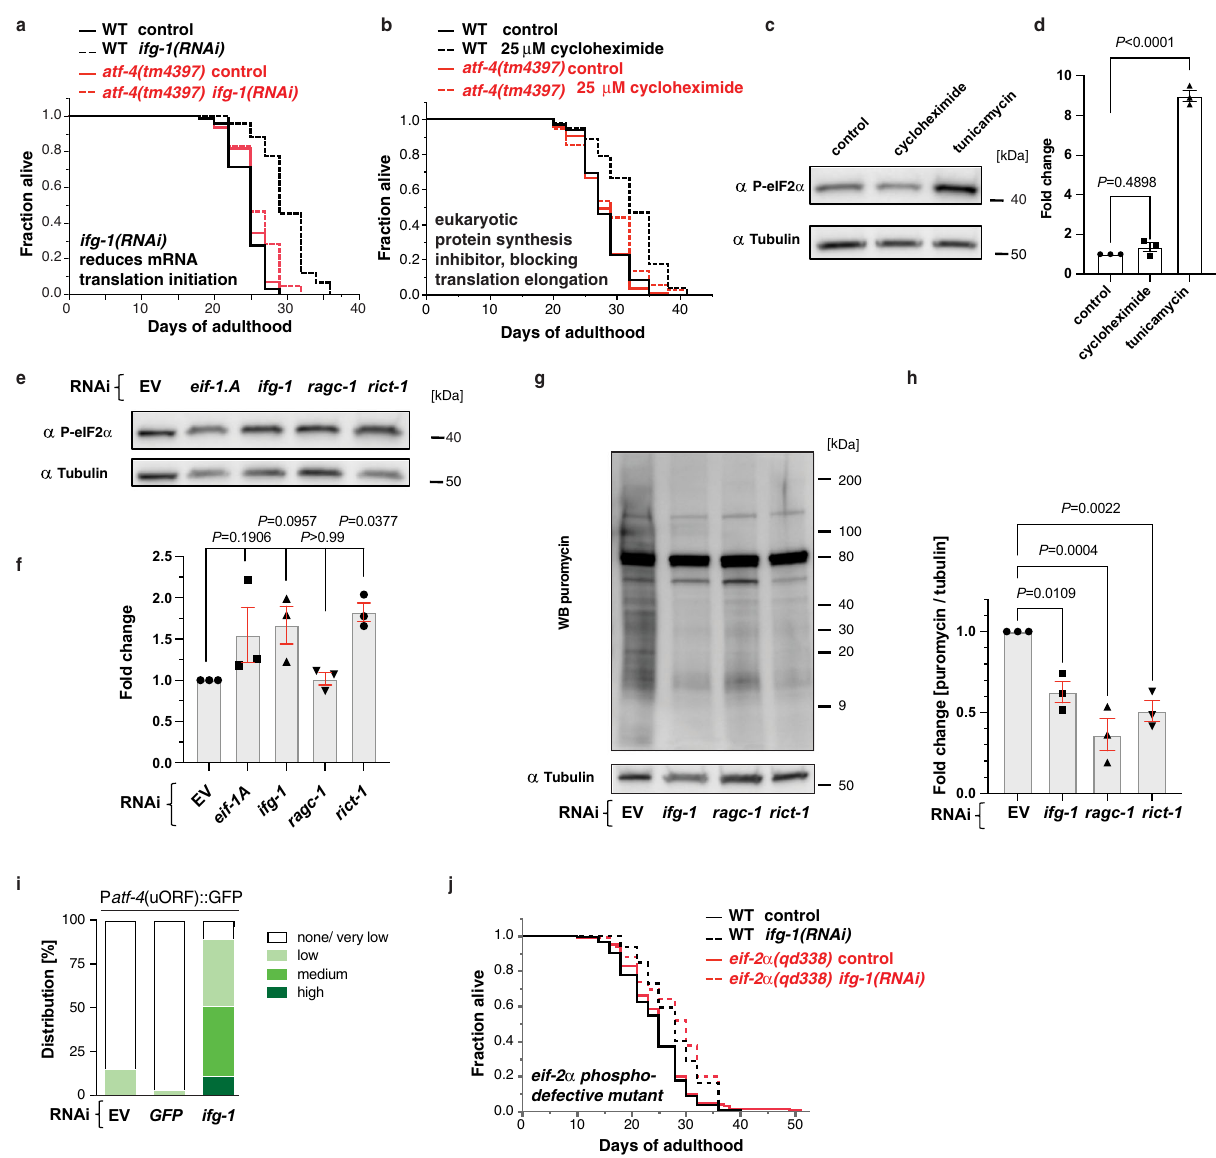
Fig. 2 ATF-4 mediates lifespan extension from translation inhibition. a Adult-speci fi c knockdown of ifg-1 extended the lifespan of WT animals but not atf- 4(tm4397) mutants. b Adult-speci fi c treatment with 25 μ M cycloheximide increased lifespan dependent upon atf-4 . c Representative western blots and quanti fi cation ( d ) showing that treatment with 35 μ g/ml tunicamycin for 4 h dramatically increased eIF2 α phosphorylation levels in L4 stage animals, while treatment with 7.2 mM cycloheximide for 1 h did not. Mean± SEM. n = 3 biological replicates. One-way ANOVA with post hoc Tukey. e Representative western blots and quanti fi cation ( f ) showing the effects of adult-speci fi c knockdown of eif-1.A , ifg-1 , ragc-1 , or rict-1 on eIF2 α phosphorylation levels. Mean± SEM. n = 3 biological replicates. One-way ANOVA with Dunnett ’ s post-test compared to EV. g Representative western blots of puromycin incorporation assay and quanti fi cation ( h ) showing that adult-speci fi c knockdown of ifg-1 , ragc-1 , or rict-1 decreased translation. Mean ± SEM. n = 3 biological replicates. One-way ANOVA with Bonferroni post-test. i Quanti fi cation of GFP fl uorescence showing that adult-speci fi c ifg-1 knockdown increases expression of P atf-4 (uORF)::GFP. j Adult-speci fi c knockdown of ifg-1 comparably extended the lifespan of WT animals and eif-2 α / y37e3.10(qd338) phosphorylation-defective mutants. For statistics and additional trials in ( a ), ( b ), and ( j ), see Supplementary Data 1. For western blots, source data are provided in Source data File. Fig. 3c, d). Notably, ATF-4 overexpression upregulated several suggesting that ATF-4 functions in tandem with HSF-1/HSF1. small heat shock protein (HSP) genes that are also controlled by Together, the data suggest that ATF-4 enhances proteostasis HSF-1/HSF (heat shock factor) and DAF-16/FOXO (Fig. 3d), and mechanisms that have been linked to longevity. are typically induced by longevity-assurance pathways 1 . Each of Other fi ndings further linked ATF-4 to longevity-associated the ATF-4-upregulated chaperone genes sip-1 /CRYAA, hsp-70 / mechanisms. ATF-4 overexpression increased expression of the HSPA1L, hsp-16.2 /HSPB1, and hsp-12.3/HSPB2 was required for cytoprotective gene nit-1/ Nitrilase (Fig. 3d), a canonical target of lifespan extension from ATF-4 overexpression (Supplementary the xenobiotic response regulator SKN-1/NRF 25 , along with expression of collagen genes that are typically upregulated by Fig. 3e; Supplementary Data 1). Translation of atf-4 was increased SKN-1/NRF in response to lifespan extension interventions within minutes by a heat shock (Supplementary Fig. 3f), NATURE COMMUNICATIONS| (2022) 13:967